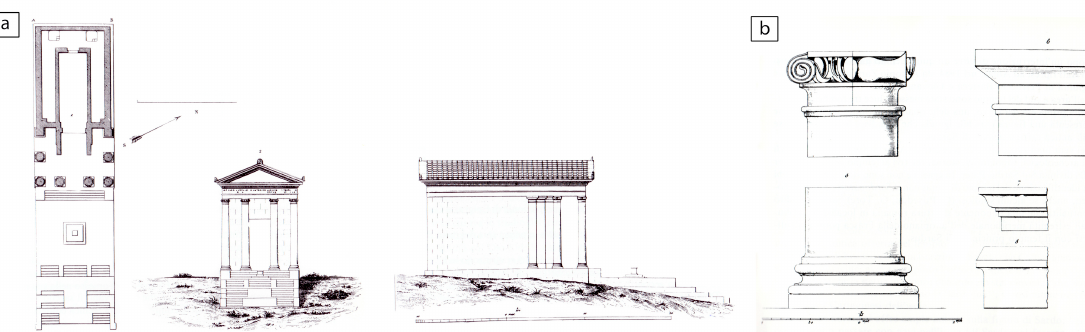
Figure 3. ( a ) Relief and ideal reconstruction of the temple of Antas by the architect Gaetano Cima (from Lamarmora [40]); ( b ) fragments of columns and capitals drawn by the architect Gaetano Cima (from Lamarmora [40]).